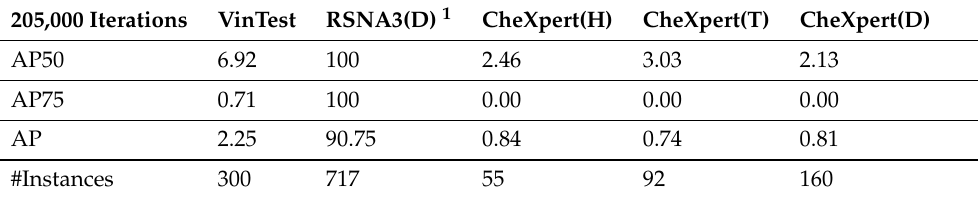
Table 6. Lung lesion detection training on VinBig and